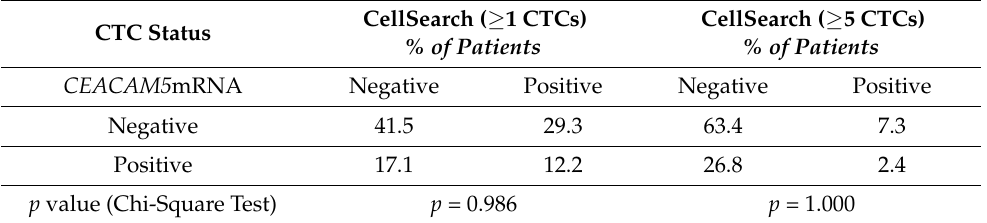
CellSearch ( ≥ 5 CTCs) % of Patients